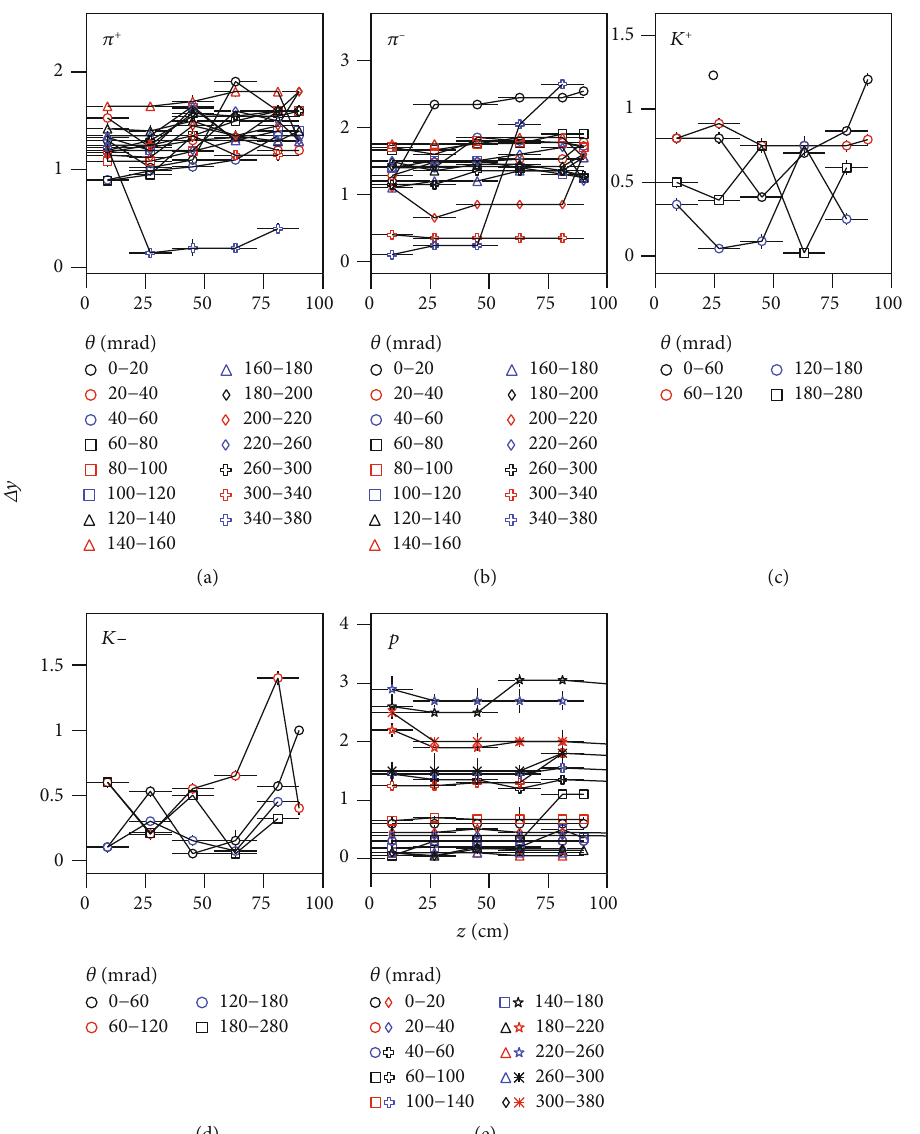
− y > 1 Þ in panel (e) represents mainly the rapidity L max L min